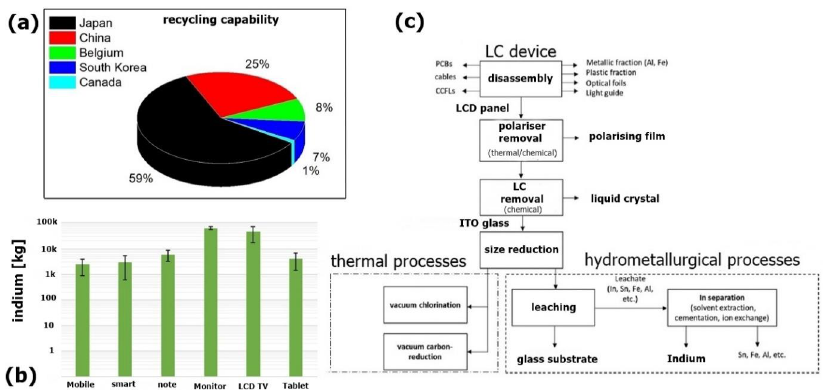
Figure 3. ( a ) Main countries with a recycling capability for indium. ( b ) Worldwide recycled mass of indium for different liquid crystal display technologies 2013 (note the logarithmic scale) [Reproduced by permission from ref. [8]]. ( c ) General block diagram of a simple recycling process for LCD devices. [Reproduced by permission from [10]).